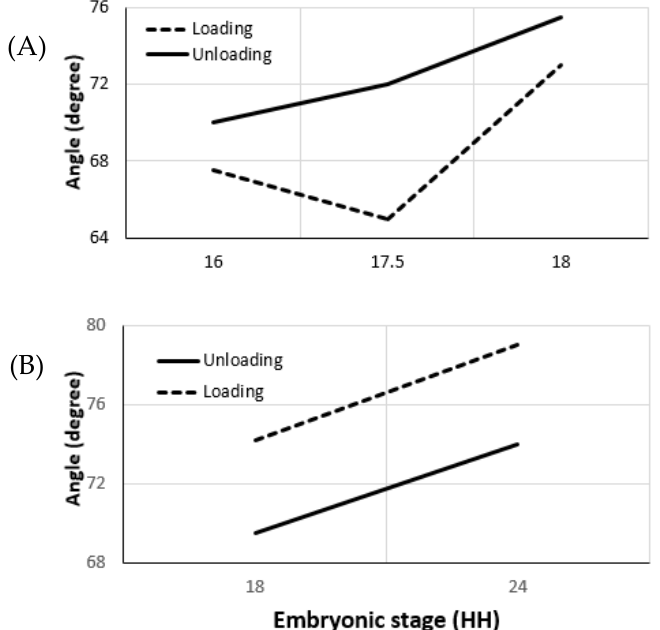
Figure 4. Changes in the effective opening angles of chick embryo arteries during early development are plotted. ( A ). Opening angle for vitelline arteries at stages HH16, HH17.5, and HH19 during loading and unloading conditions. ( B ). Opening angles for IVth right aortic arch at stages HH18 and HH24. Plots represent typical data collected over 13 chick embryos. Opening angles were calculated in our lab using the methodology presented in [12] using OCT and servo-null pressure data.